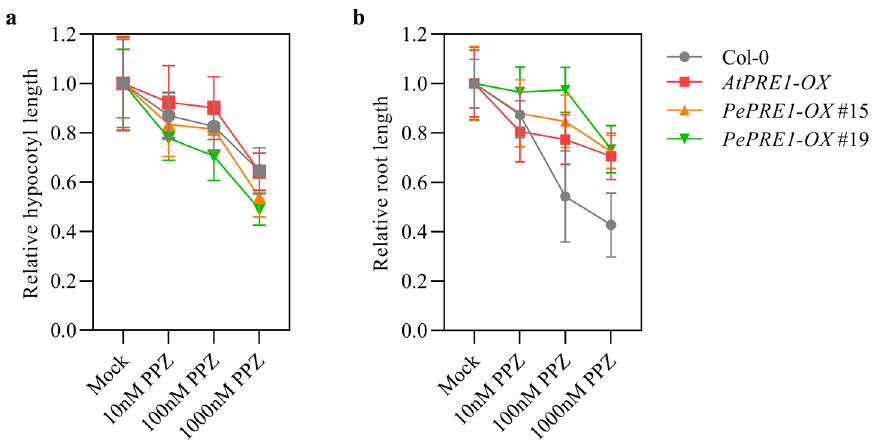
Figure A2. The morphology of T1 transgenic plants overexpressing PePREs ( 35S:: PePRE1-GFP #19 phenotype) in Arabidopsis . The plants were grown in a growth room for 4 weeks.